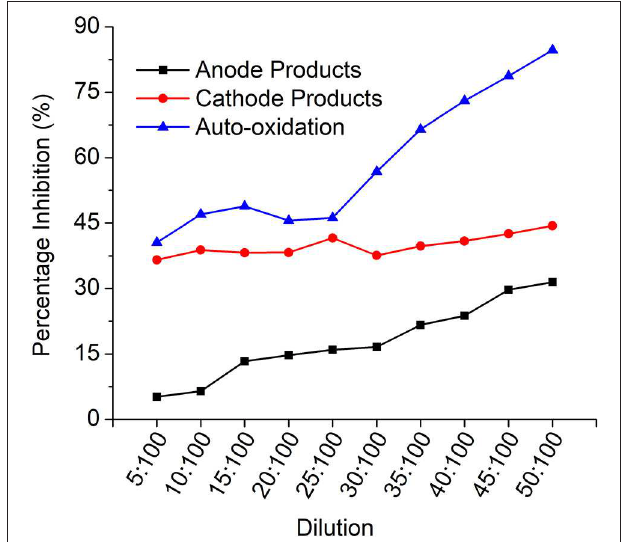
FIGURE 9 | Vibrio fischeri toxicity profile indicating the % inhibition for each dilution for all the products.